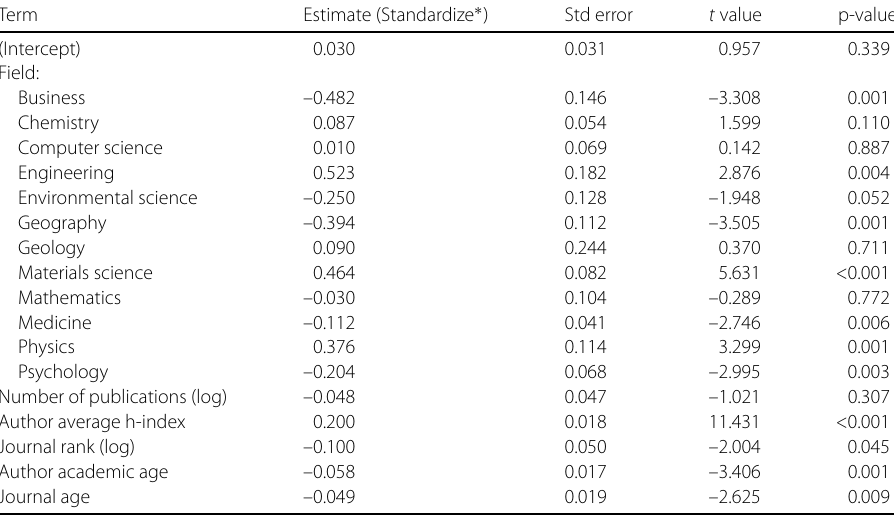
Table 2 Linear regression (standardized coefficients) on journals’ proportion of publications with accessibility